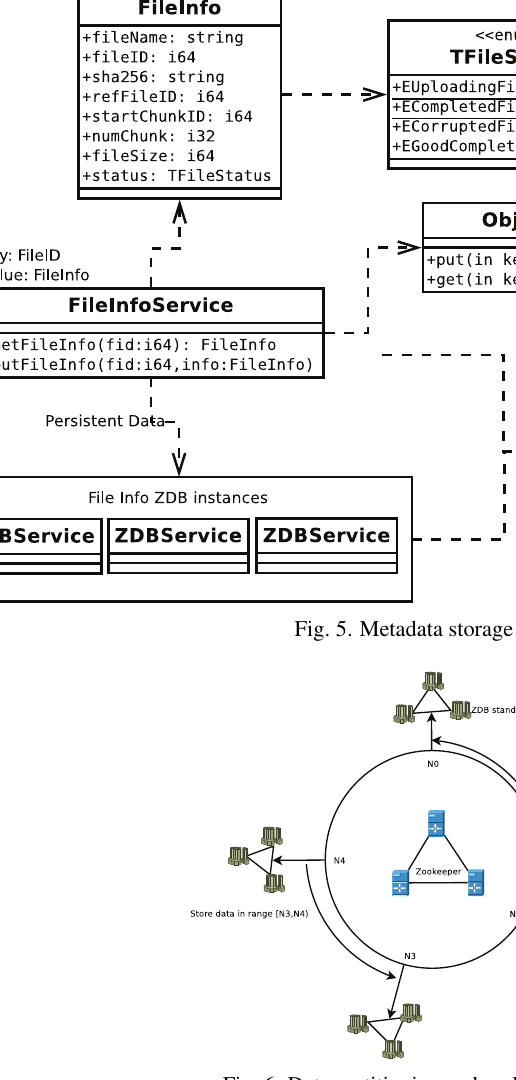
Fig. 6. Data partitioning and replication from